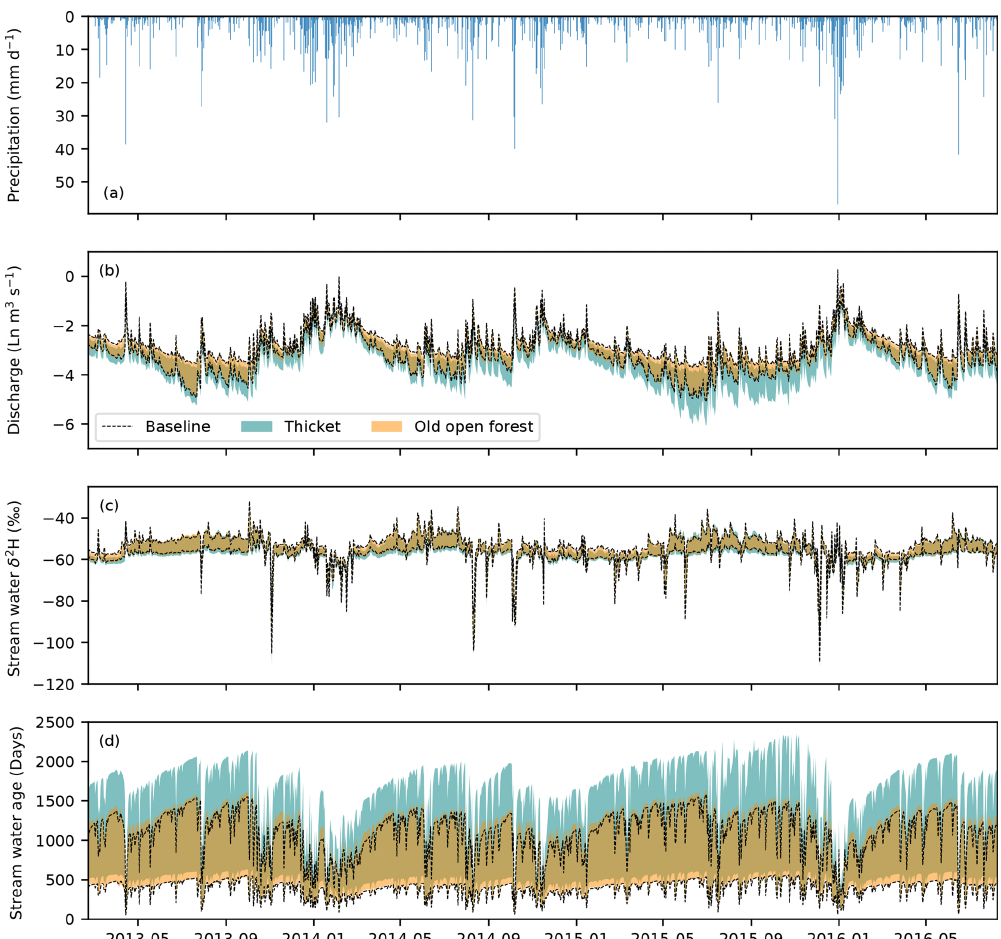
Figure 5. Time series of the (a) observed precipitation and the simulated (b) natural logarithm (Ln) of stream discharge. (c) Stream water δ 2 H composition. (d) Stream water age. In panels (b) to (d) , the area between the two black lines represents the 90% spread of behavioural simulations for the baseline scenario, while the shaded areas show the same for the thicket and old open forest scenarios. Areas of darker, gold-coloured shading occur where simulations for the two regeneration scenarios